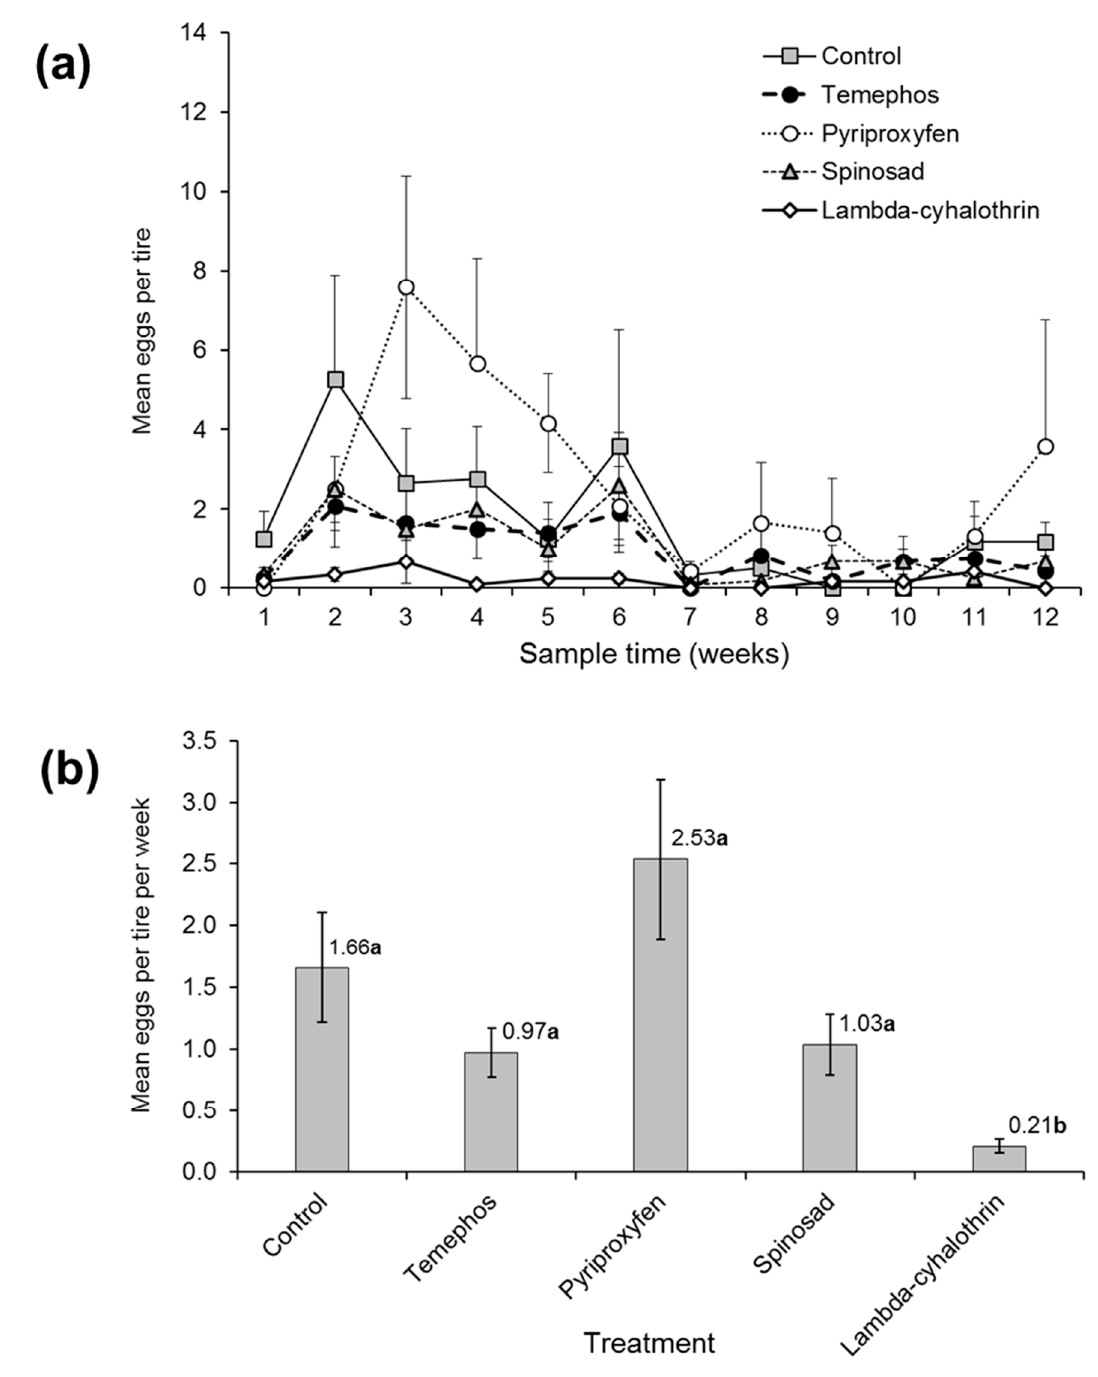
Figure 2. The effect of treatments on ( a ) the mean number of Aedes spp. eggs laid on filter paper strips in each tire during the 12-week post-treatment period. ( b ) The overall mean number of Aedes eggs per tire per week over the entire post-treatment period. The vertical bars indicate SE. The values above columns in ( b ) indicate the mean. Values followed by identical letters did not differ significantly (Tukey, p > 0.05).